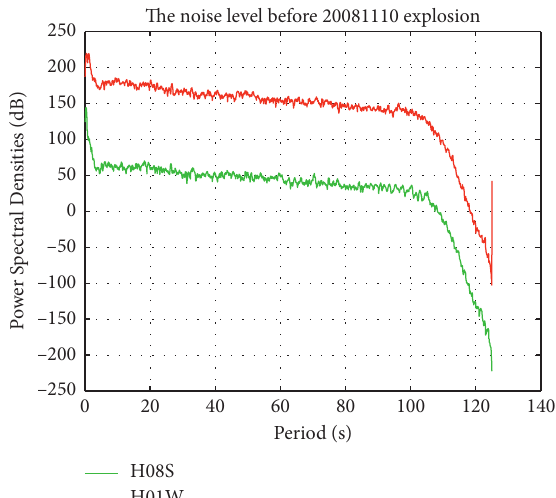
Figure 6: Background noise level compared between the H08 south station and H01 west station before the blast on November 10,